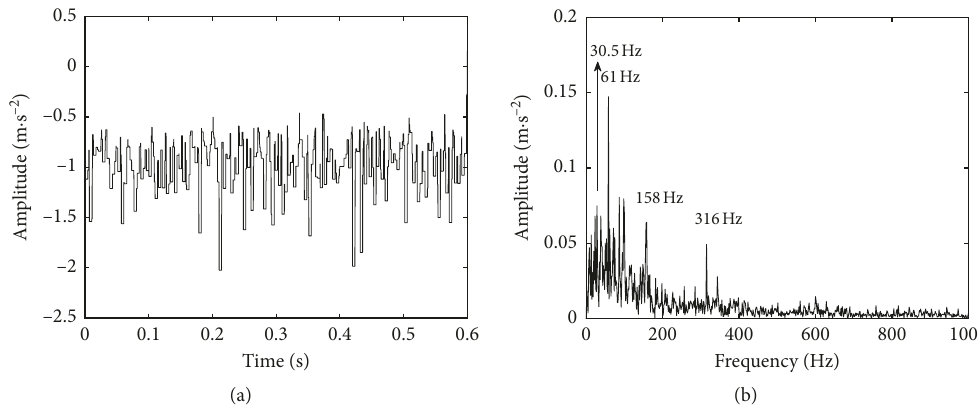
Figure 6: Erosion results of CSE. (a) Waveform in the time domain. (b) Frequency